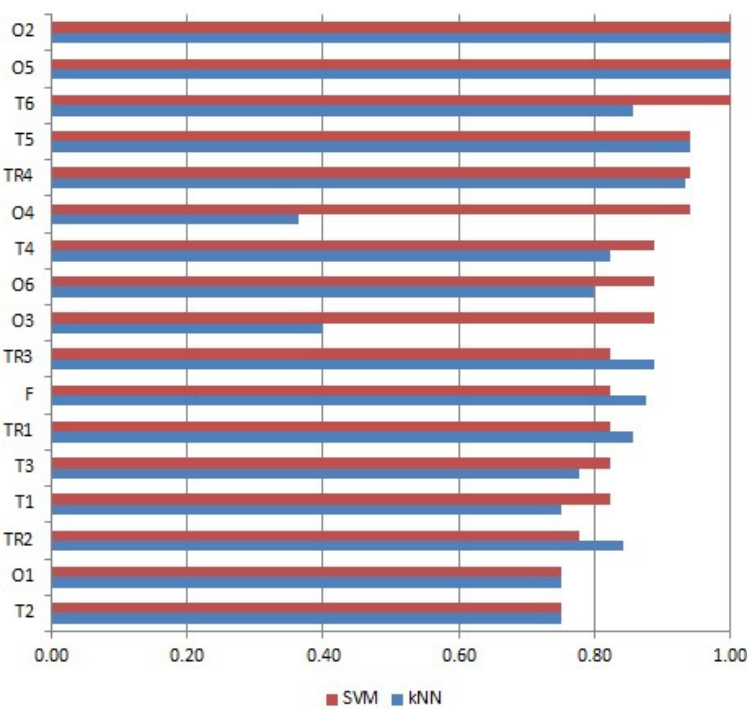
Figure 5. F-score ranking of importance of subsets formed from selected compounds obtained with the use of SVM and kNN methods (see Table 4 for notations).